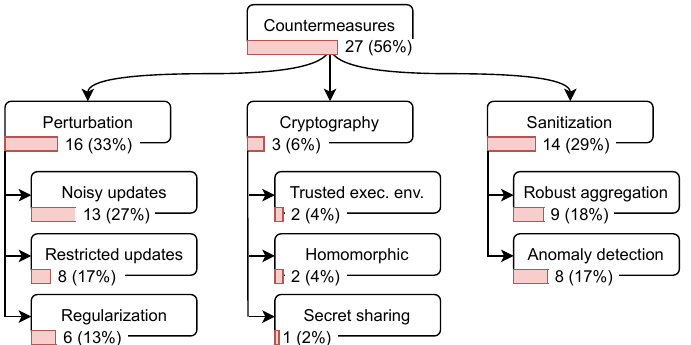
Figure 9. Countermeasures’ classification with the papers’ distribution. The percentage is with regard to the total number of papers, 48. Some categories are not exclusive; therefore, the papers might sum up to more than 48. More details on the individual papers can be found in Table 5. Only 55% of the attacks are evaluated against countermeasures. Noisy update is the most used technique with